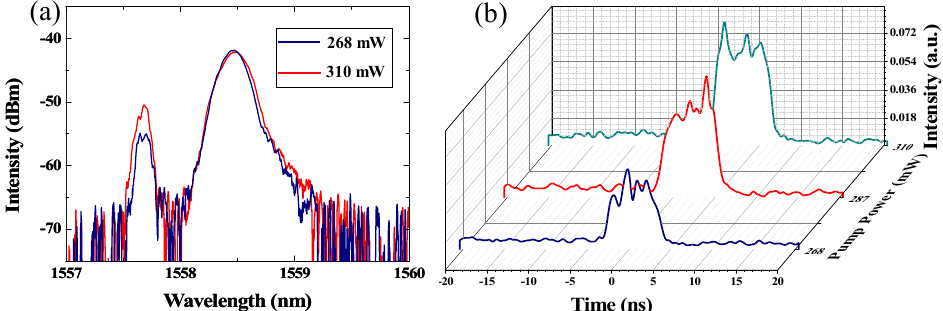
Figure 7. ( a ) Output optical spectra versus pump power, and ( b ) pulse waveform versus pump power.